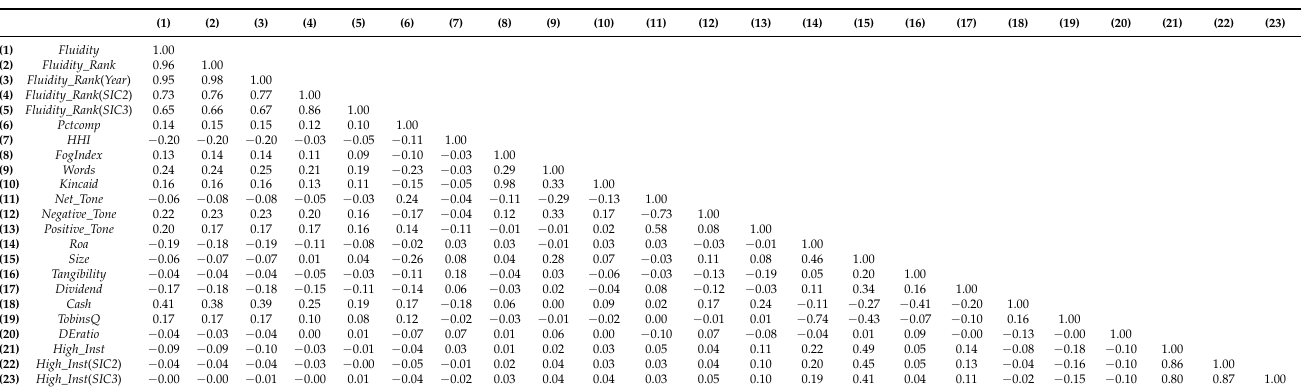
Table A2. Variable pairwise correlations.